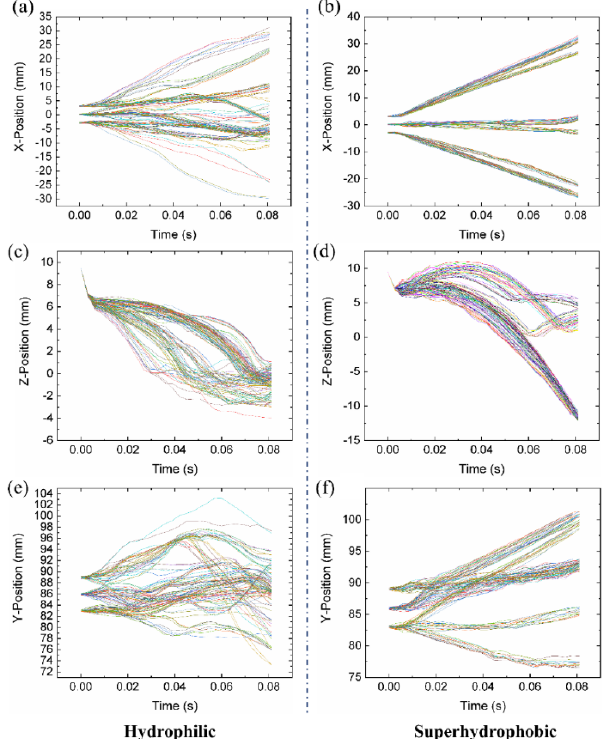
Figure 10. Coordinate changes of the simulated traces on the hydrophilic and superhydrophobic models. The staggered traces shown on the left ( a , c , e ) are on a hydrophilic substrate, implying that wetting occurs even while moving. The difference appears in the model after superhydrophobic modification, and the trend increases or decreases significantly. This suggests that droplets impacting a moving model are accelerated to bounce off ( b , d , f